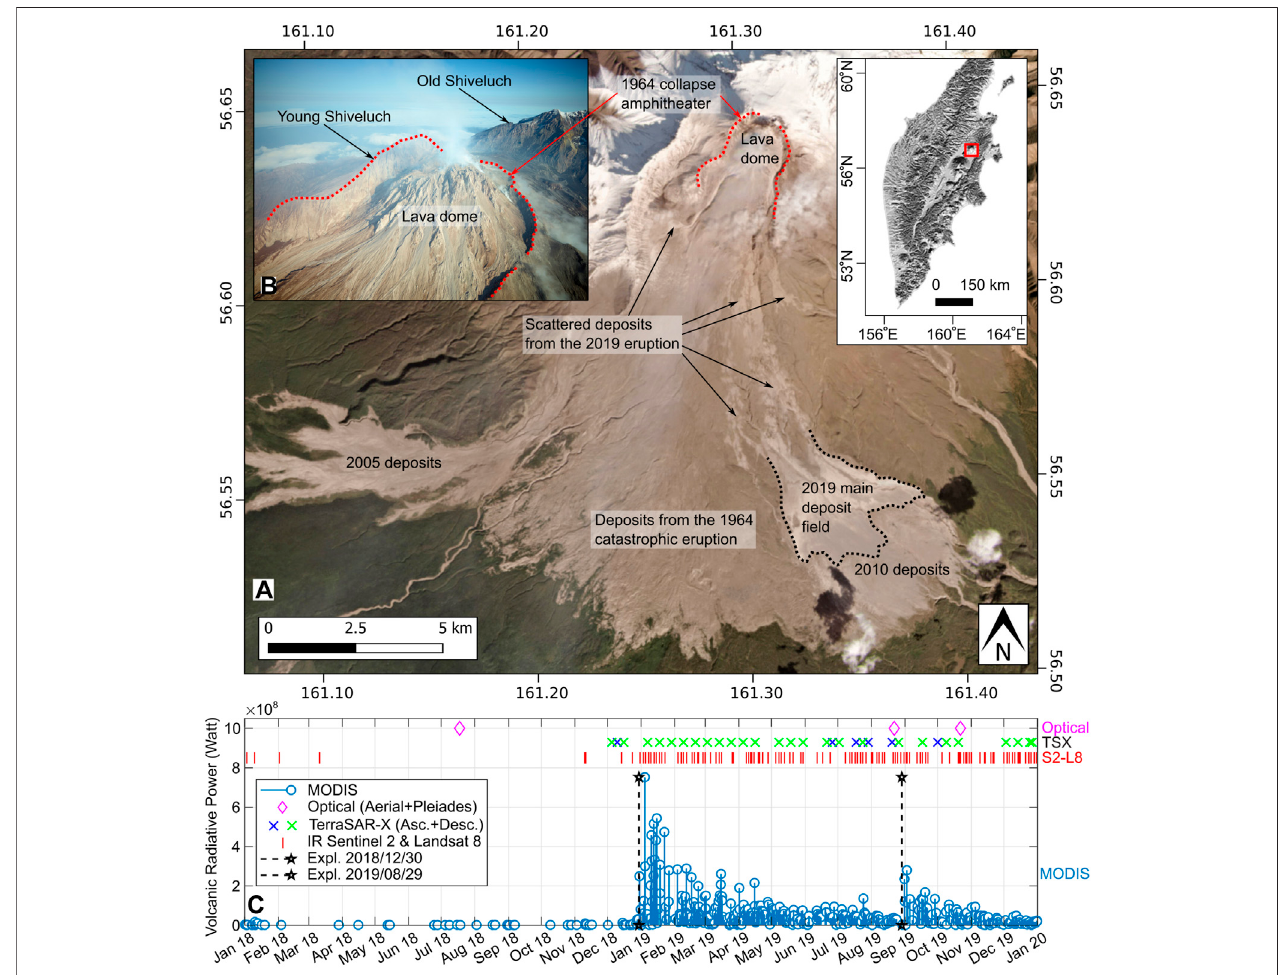
FIGURE 1 | Shiveluch volcano and its deposit fi eld (A) Optical image from the Dove satellite (Planet Labs, Inc.https://api.planet.com) acquired on September 13, 2019 showing the location of the active lava dome encircled by the 1964 collapse amphitheater (red dotted line), from which all subsequent eruptive deposits (labeled 1964,2005,2010,and 2019)spread outward toward thesouth. Thescattered deposits fromthe2019eruptionarevisibleand markedbyblackarrows. Theupperright inset map shows the location of the volcano (red square) on the Kamchatka Peninsula (B) Oblique helicopter fl ight view to the north showing the Shiveluch lava dome on August 22, 2019. The 1964 collapse amphitheater is delineated by a red dotted line. The map was generated using ArcGIS 10.2.1 in the WGS84 coordinate system (C) Data used in the investigation. The high-resolution optical data (diamonds) acquired before and during the eruption were used for topographic analysis and compared withthe TSX satellite radar data(green triangles). The thermal emissionswere analyzed using theSentinel2and Landsat 8satellites (red bars). Bluelineswith circles summarize the 2018 – 2019 VRP time series (in watts) provided by the MIROVA system (www.mirovaweb.it). Black stars and dotted lines mark the occurrence